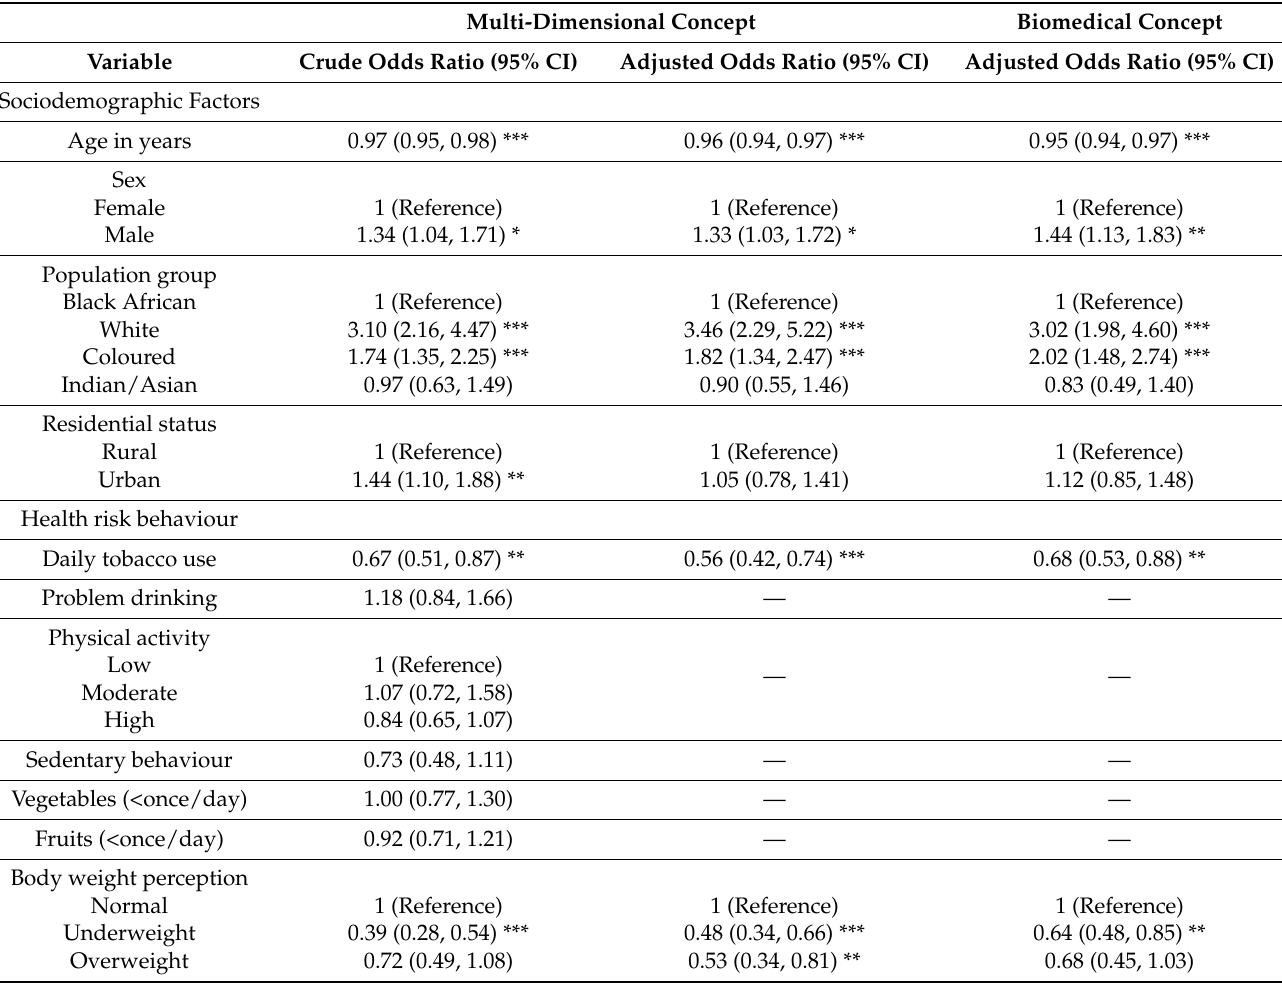
Table 3. Associations with healthy